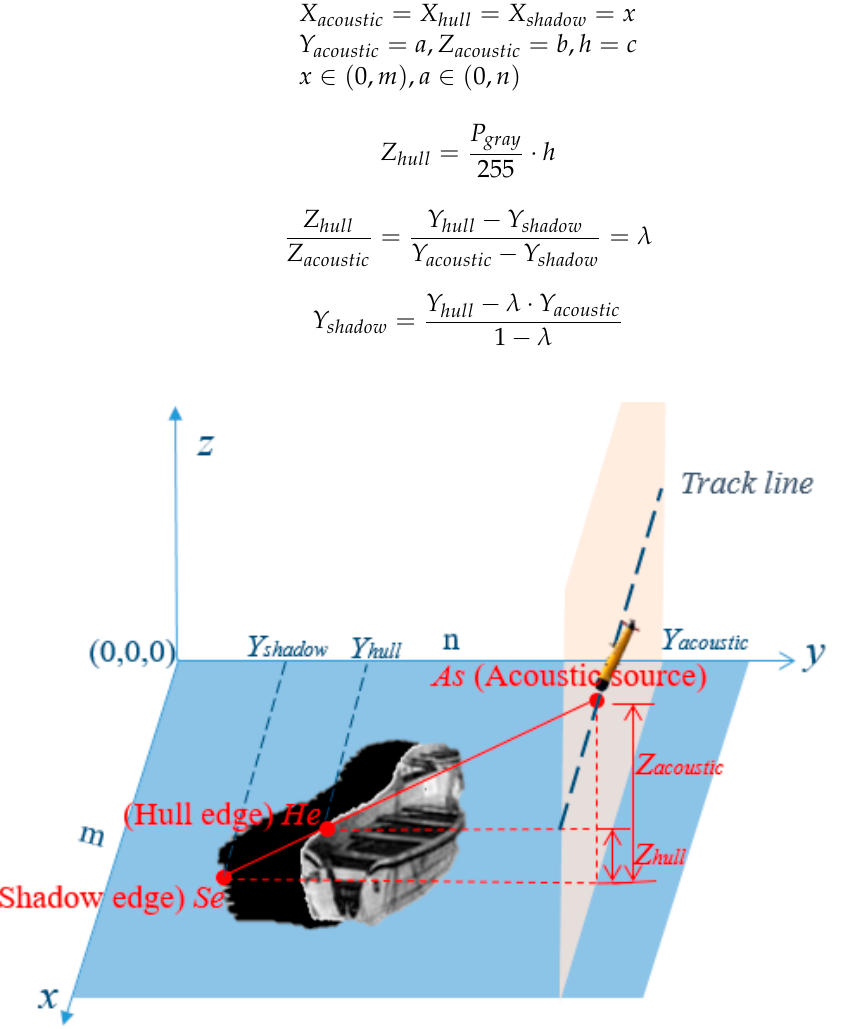
Figure 9. Shadow